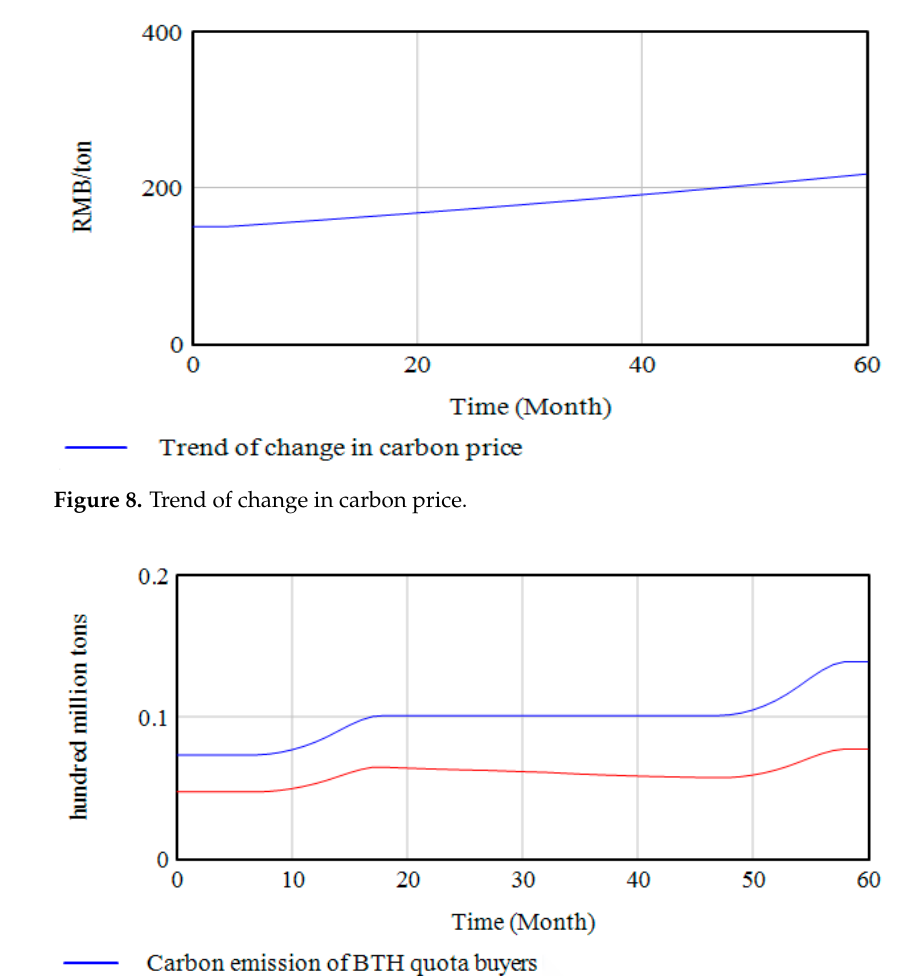
Figure 8. Trend of change in carbon price.